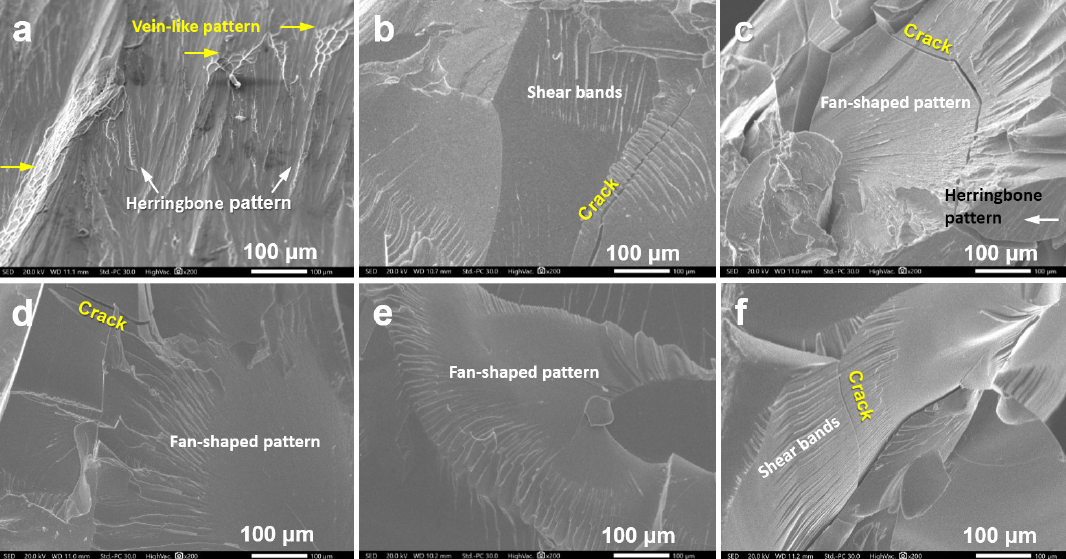
Figure 7. SEM images of fracture morphologies of the experimental alloys: ( a ) original Mg-Zn-Ca amorphous alloy; ( b ) Sample 1; ( c ) Sample 2; ( d ) Sample 3; ( e ) Sample 4; ( f ) Sample 5.